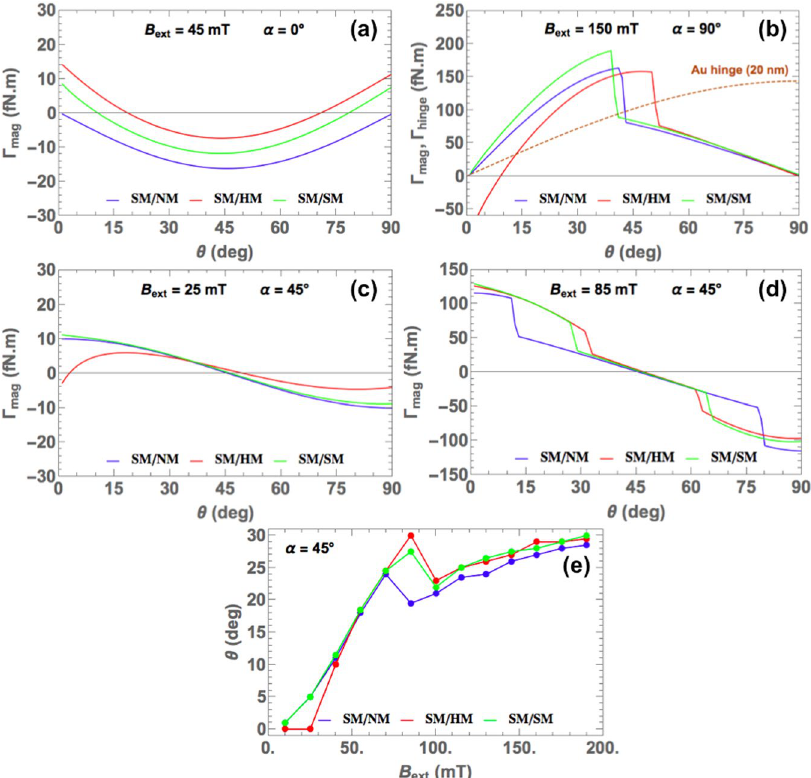
Figure 4. For the three types of tweezers, the magnetic torque is calculated as a function of opening angle for different field angles ( a ) α = 0°, ( b ) α = 90°, ( c , d ) α = 45°. The elastic torque stemming from the Au nanohinge is shown only in ( b ). ( e ) The equilibrium opening angle at α = 45° is determined by intersecting the magnetic torque and elastic torque curves for several amplitudes of magnetic